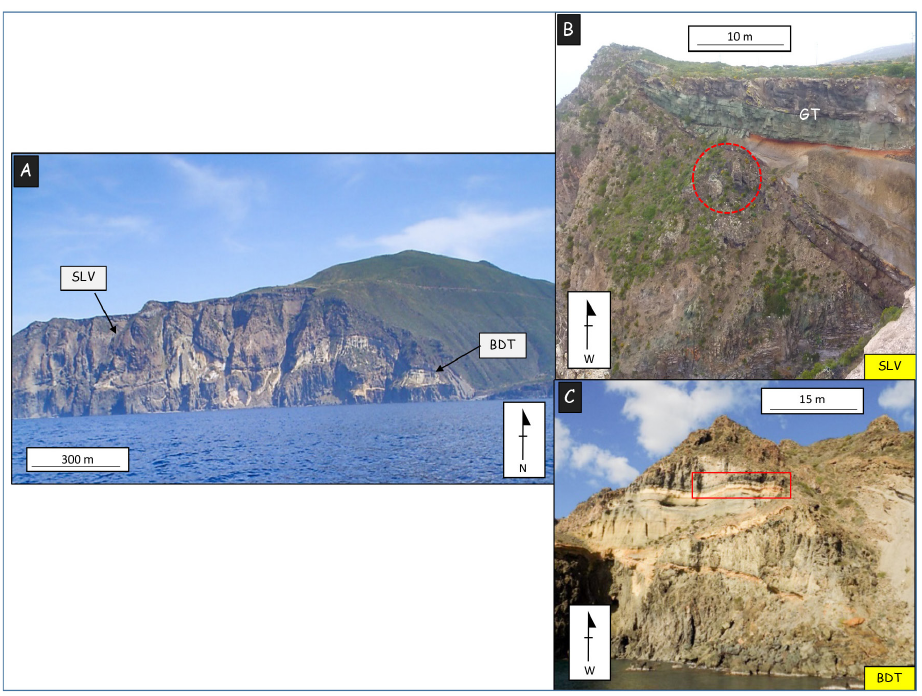
Figure 3: ( A ) The southern sites of Salto la Vecchia (SLV) and Balata dei Turchi (BDT) in a wide angle and mid-distance view. ( B ) mid-distance view of the Salto La Vecchia obsidian outcrop, below which there is a 280 m vertical scar, GT = Green Tuff ignimbrite; ( C ) mid-distance view of the Balata dei Turchi